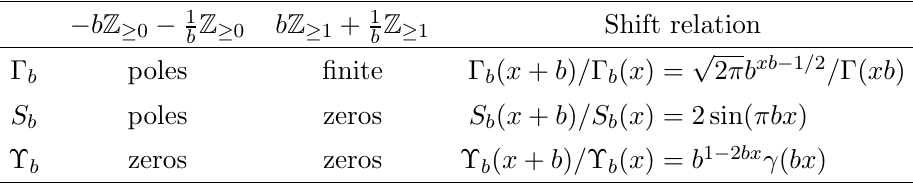
Table 1 . Properties of Barnes